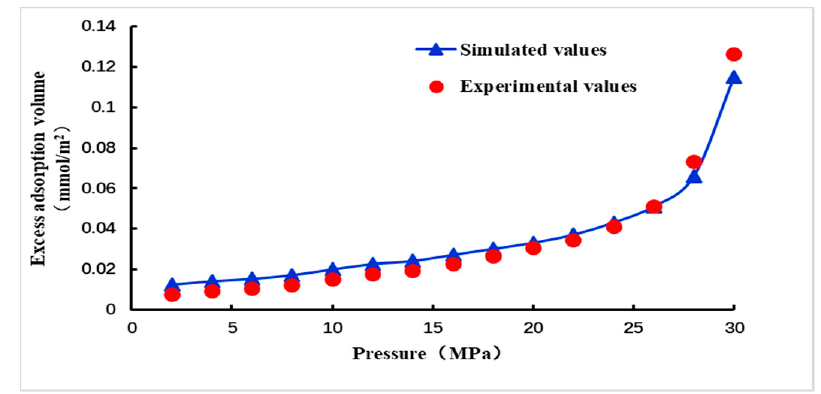
Figure 2. Comparison between simulated and experimental results.